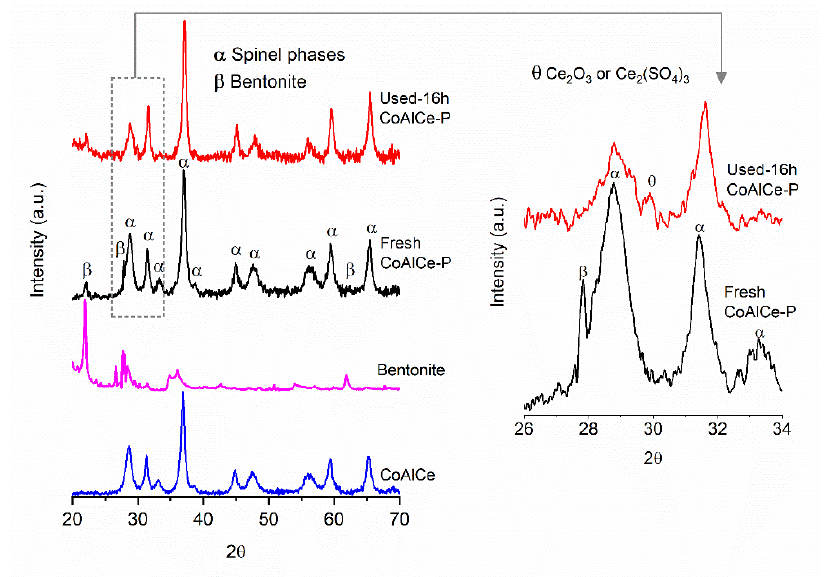
Figure 14. XRD for fresh and 16 h CoAlCe pellet catalysts.